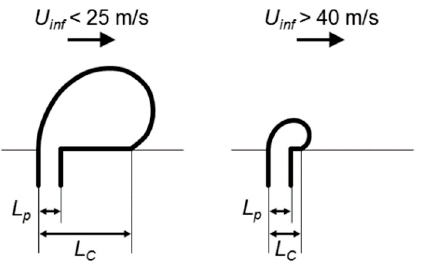
Figure 7. Schematic diagram of the contact length, L C , versus pore diameter, L P , with different air velocity. As the air velocity increases, the adhesion by the pore becomes more influential on the incipient